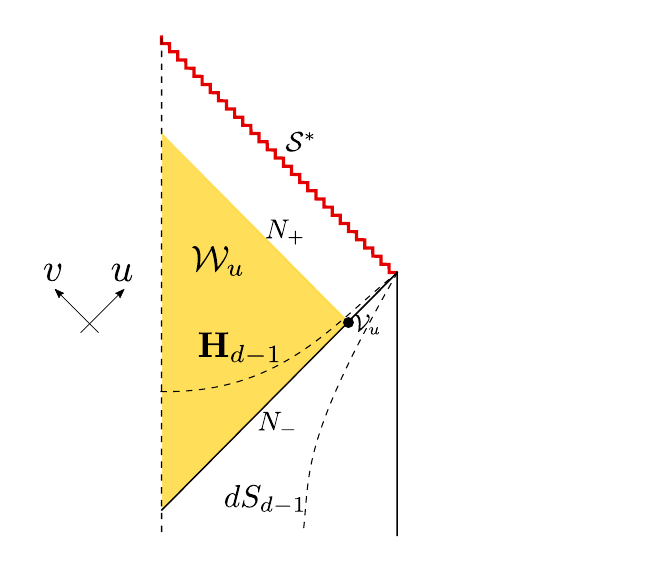
Figure 3 . The idealized state generating a null singularity by the collision of a thin-walled bubble with dS d +1 worldvolume. Notice that WdW patches anchored at the horizon do not touch the